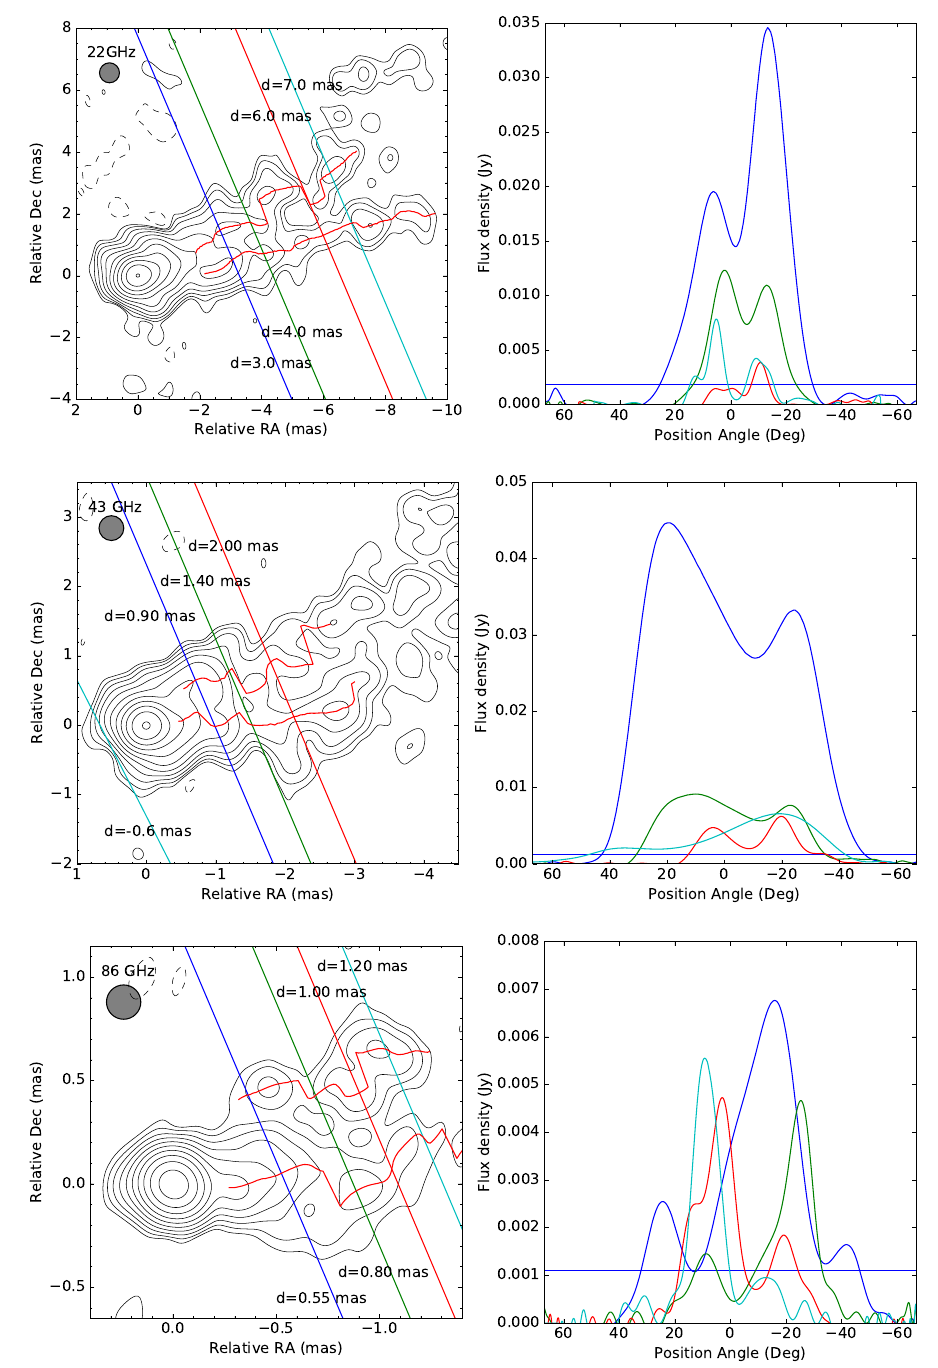
Figure 3. The left panels shows the images restored with circular beams as contours. The restored beams are shown at the top-left corner of each panel. Locations of sample slices are presented as lines superimposed on the contours. The ridgeline is presented as red curves superimposed on the contour plots. The right panels present sample slices, showing the intensity as functions of position angles PAs referring to the jet axis. The northern limb is at positive values, while its southern counterpart is at negative values. The blue horizontal lines represent 5 σ of the restored